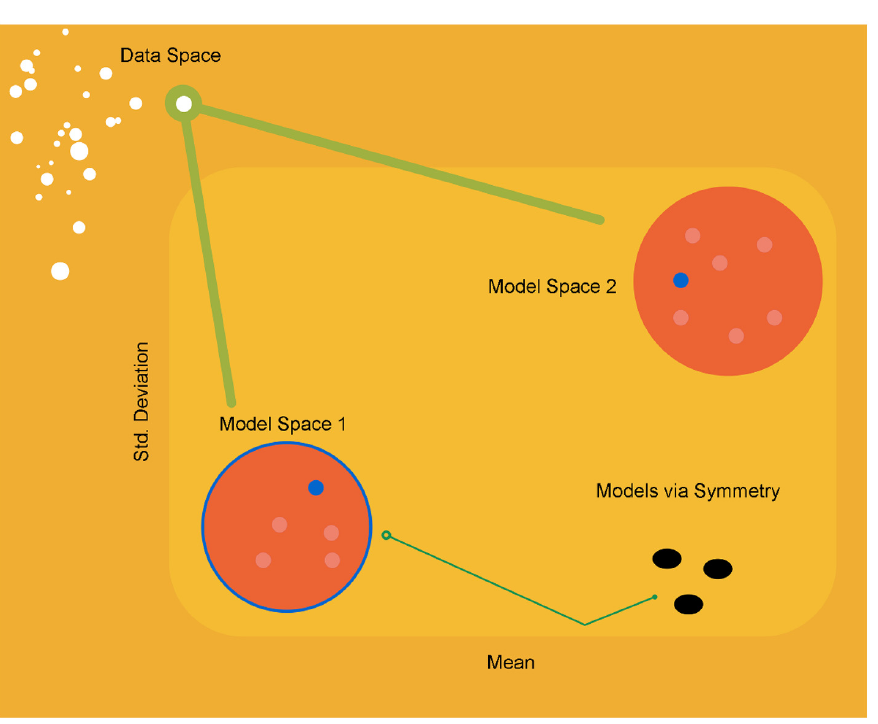
Fig 1. Invariance of inference — a proposal. A univariate normal model space (of the equivalent data space) whose coordinates are sufficient statistics. The orange circles represent two model spaces, where minimization of variational free energy leads to the appropriate model (blue circles in each case). It might be that one parameterisation (blue outer circle for model space 1) is more suitable than another. Notice that using the Riemann gradient instead of the Euclidean gradient automatically guarantees gauge-invariance by breaking the symmetry within a model. But what about between-model symmetries? After the optimal model has been selected, symmetry transformation could enable one to derive a range of models (black circles) that describe the data equally well (in terms of log model evidence or negative free energy). These can be obtained by using the intrinsic geometry of the gauge field (the Levi-Civita connection) and the symmetries afforded by the variational free